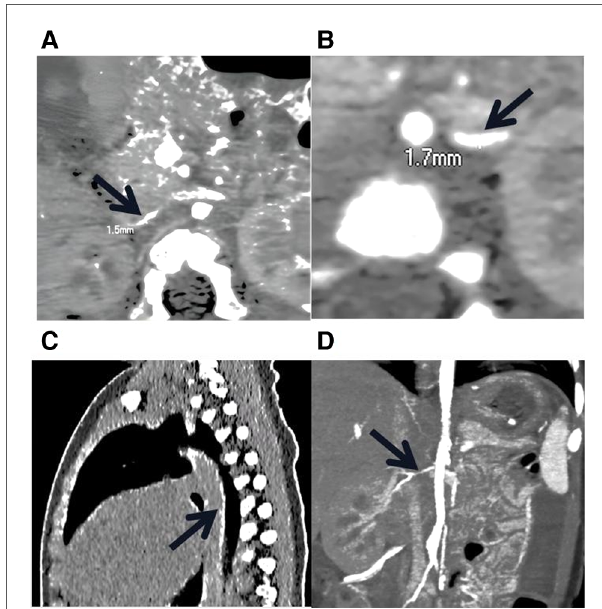
FIGURE 1 Low-dose, enhanced CT of the child with GACI caused by a homozygous variation in ENPP1 . ( A ) and ( B ) stenosis of bilateral iliac artery; the thinnest parts of the left and right iliac arteries are 1.7 mm and 1.3 mm wide, respectively. ( C ) The black arrow indicates the presence of calci fi cation in the descending aorta, thoracic aorta, and abdominal aorta. ( D ) The black arrow indicates the stenotic right renal